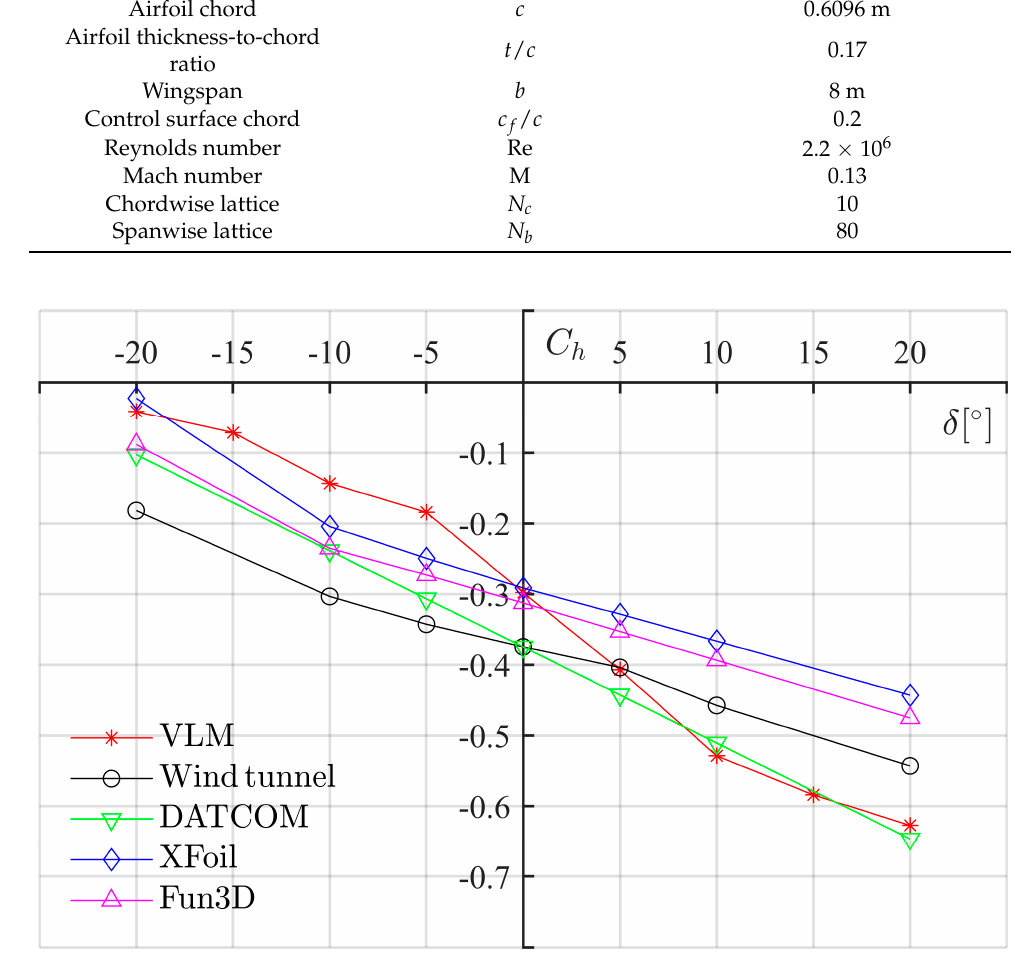
C versus δ for GA(W)-1 at alpha 20°. Figure A2. Figure A2. C h versus δ for GA(W)-1 at alpha 20 ◦ . h Table A2. Comparison of C h for GA(W)-1 at alpha 20 ◦ Table A2. Comparison of